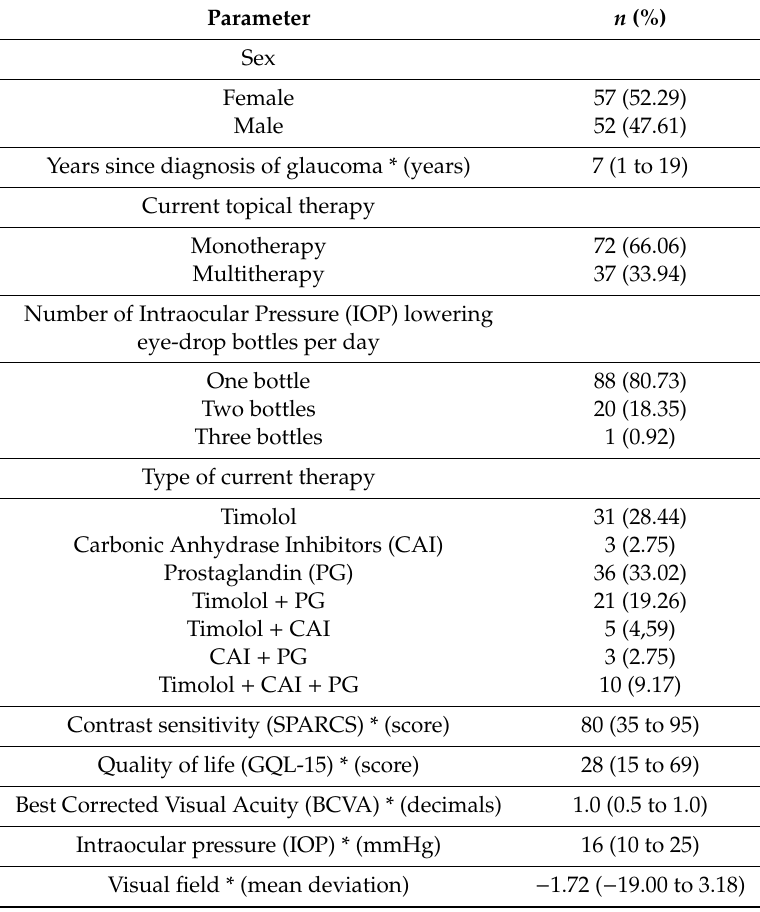
Table 1. Baseline demographic and clinical